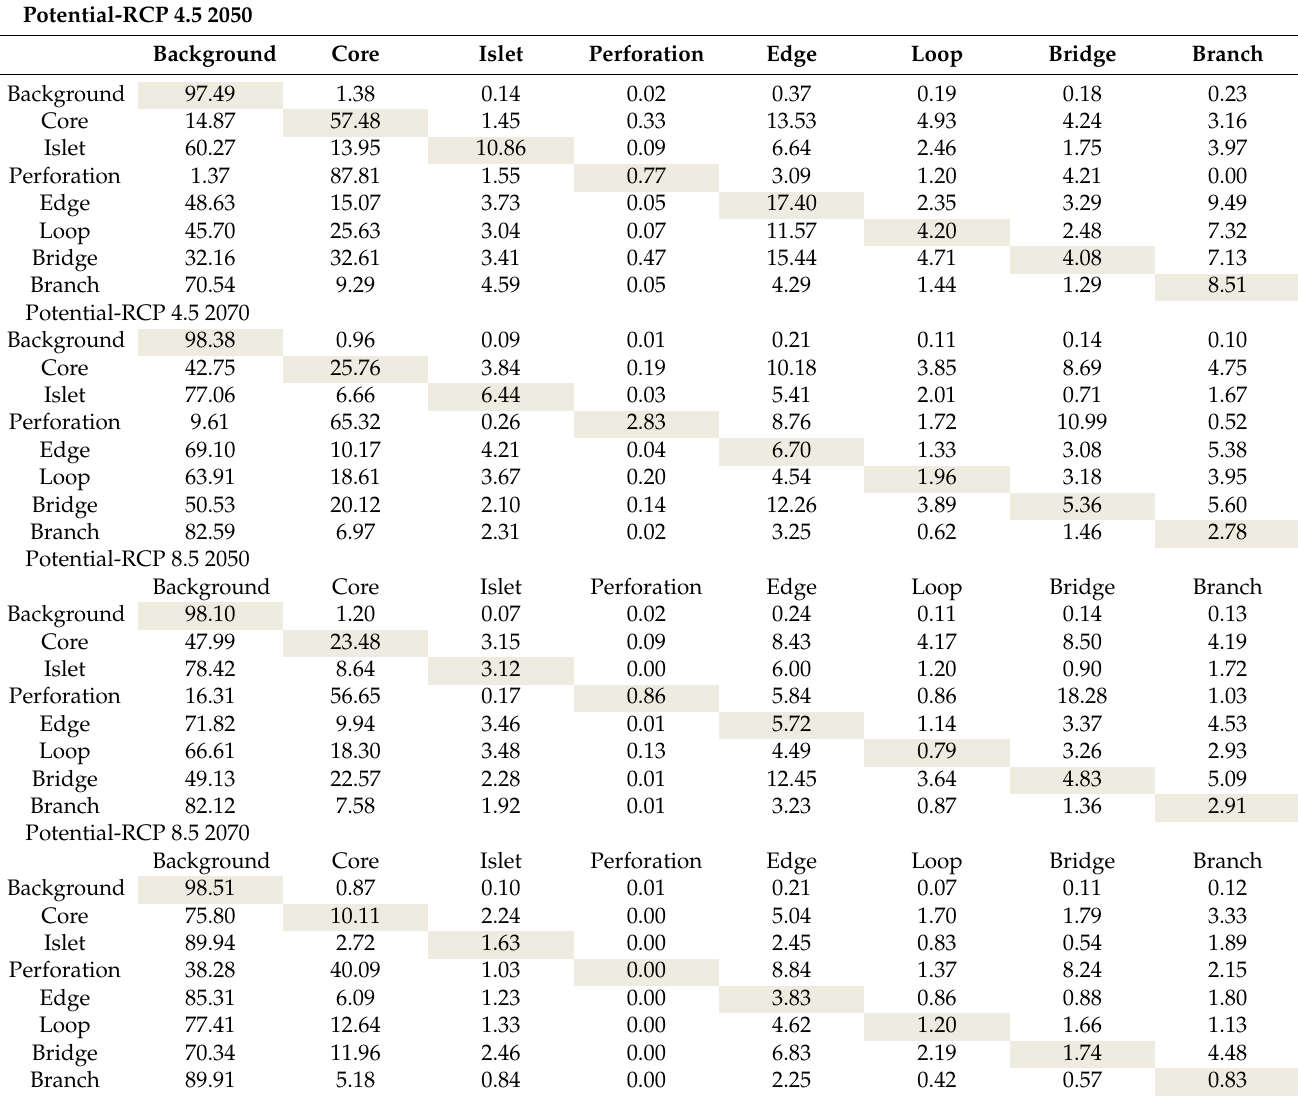
Table A1. Transition matrices showing the proportion of the landscape, in percentage that undergoes change for each of the potential combinations of MSPA categories for current and future